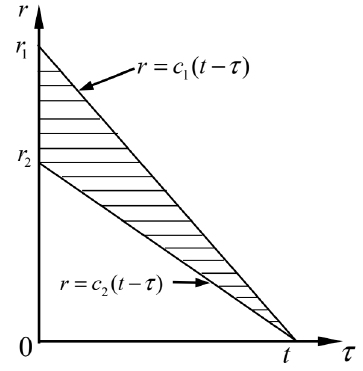
Figure 1. Sketch of time-space integration